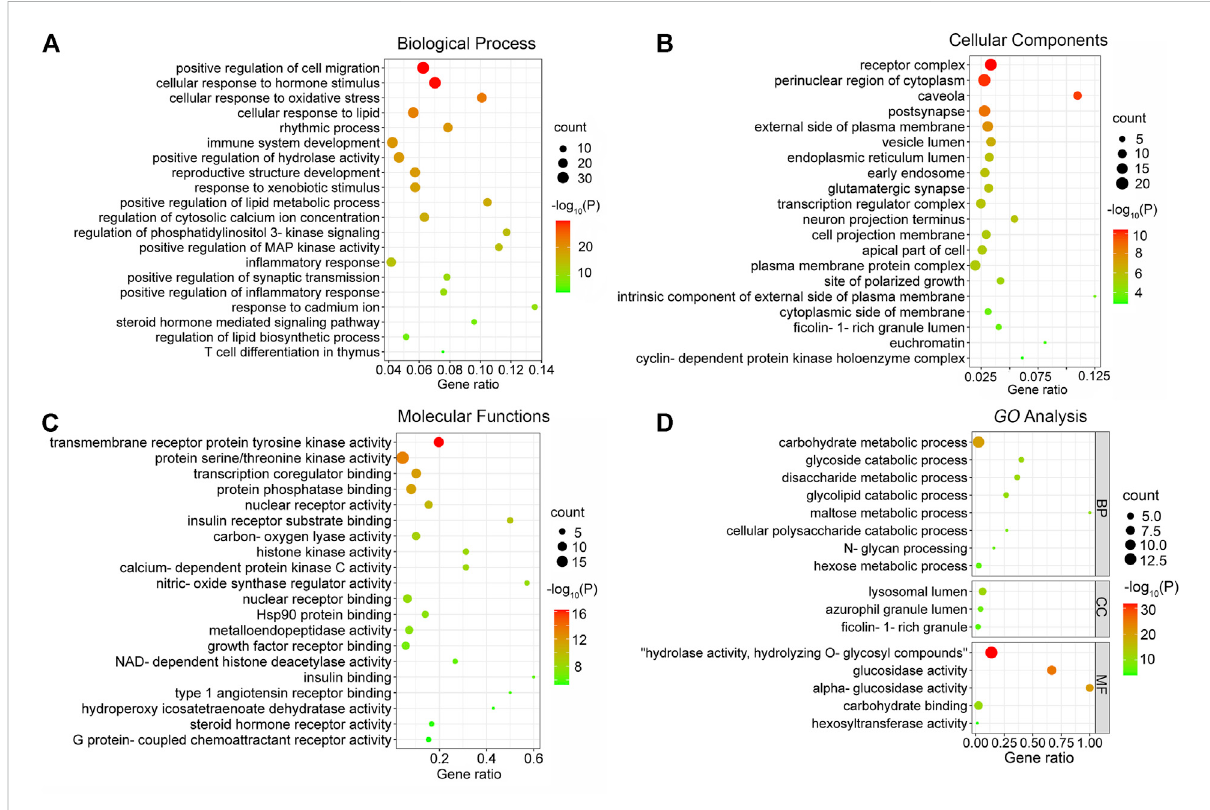
FIGURE 7 GO enrichment analysis of the antidiabetic targets of MLF and RMA. (A) Biological processes of MLF; (B) cellular components of MLF; (C) molecular function of MLF; (D) GO analysis of